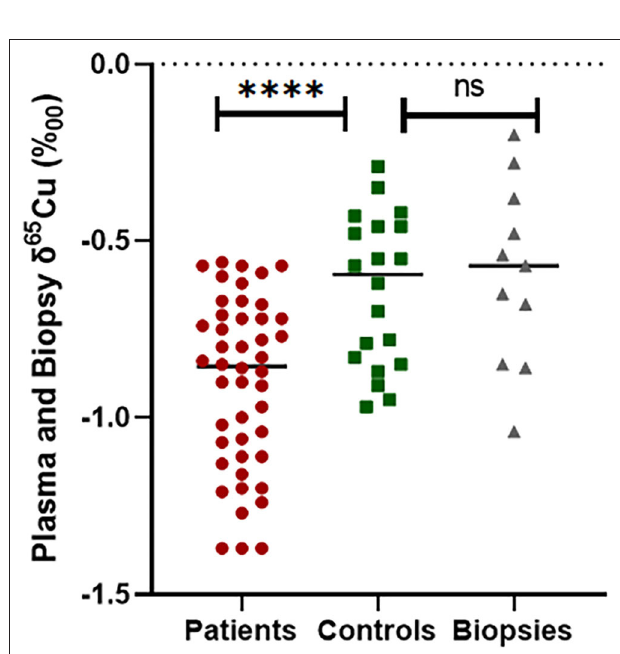
FIGURE 3 | Comparison of δ 65 Cu values between healthy controls plasma and thyroid cancer patients’ plasma and biopsy, **** p ≤ 0.0001 and ns, no significant